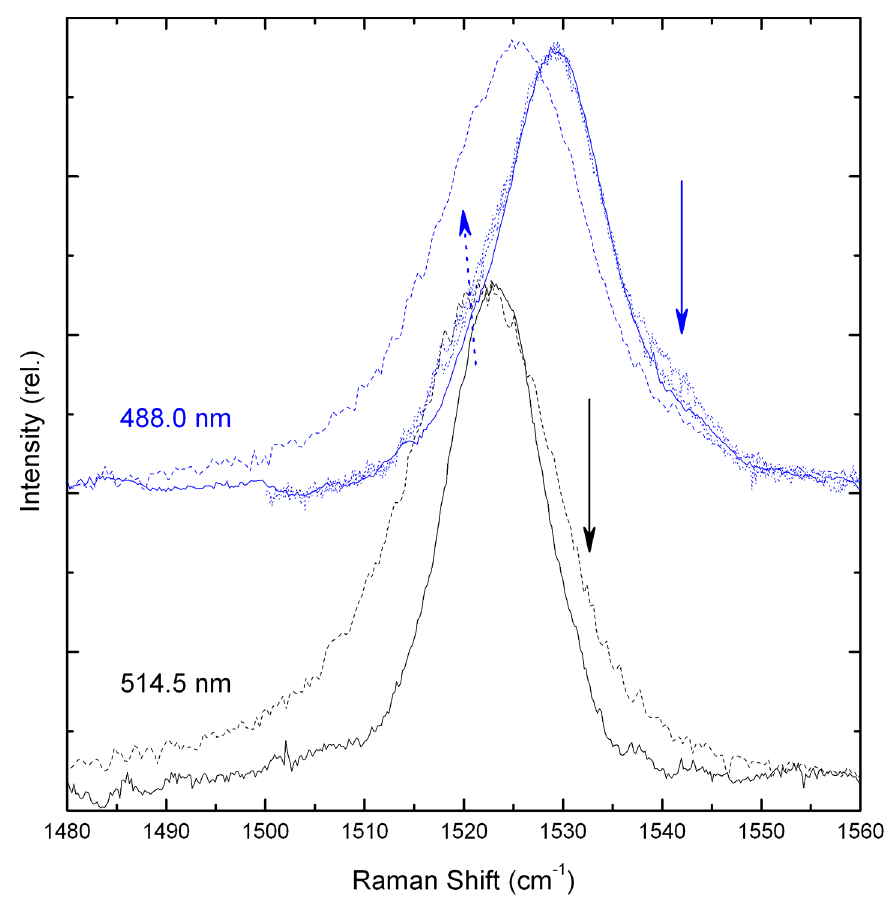
Fig 4. ν 1 region of macula resonance Raman spectra. 77 K (solid lines) and room temperature (dashed lines) spectra are shown for excitation at 488.0 & 514.5 nm (blue, black respectively). For 488 nm, additional spectra are shown for measurements scanning in towards the foveal centre (dotted